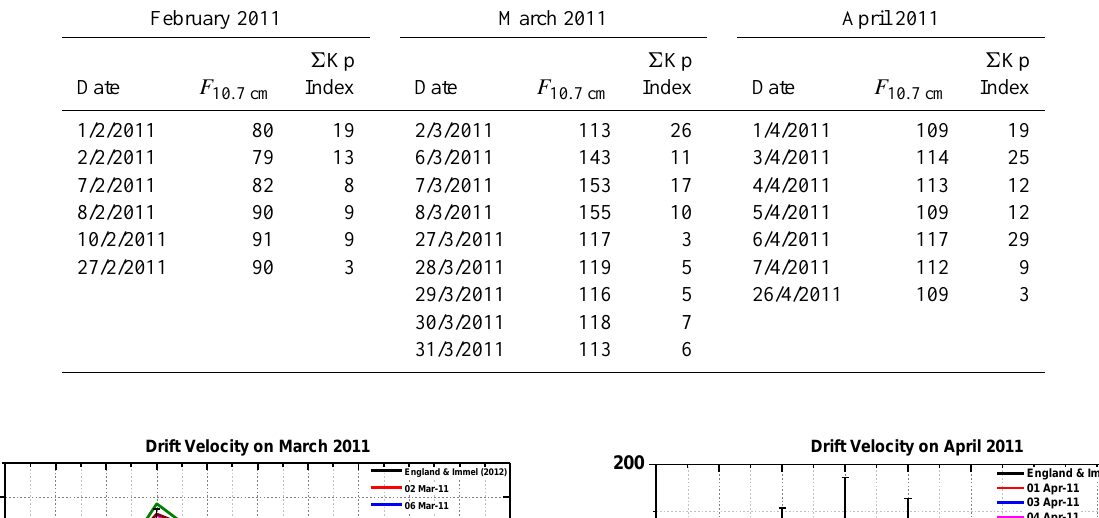
Table 1. The daily 6 Kp index and F 10 . 7 cm flux for the period of February–April 2011.